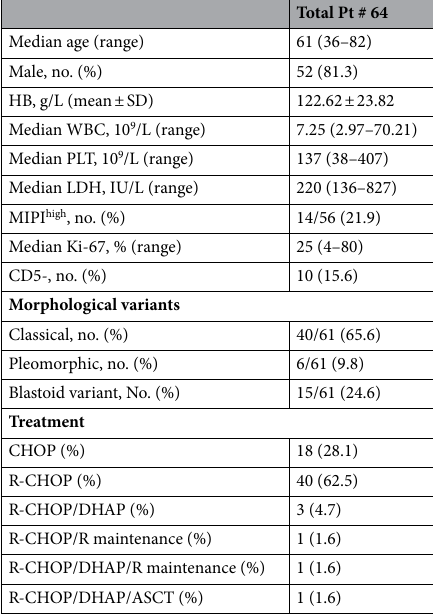
Table 1. Mantle cell lymphoma patients’ characteristics. HB hemoglobin, SD standard deviation, WBC white blood cell, LDH lactate dehydrogenase, MIPI mantle cell lymphoma international prognostic index.